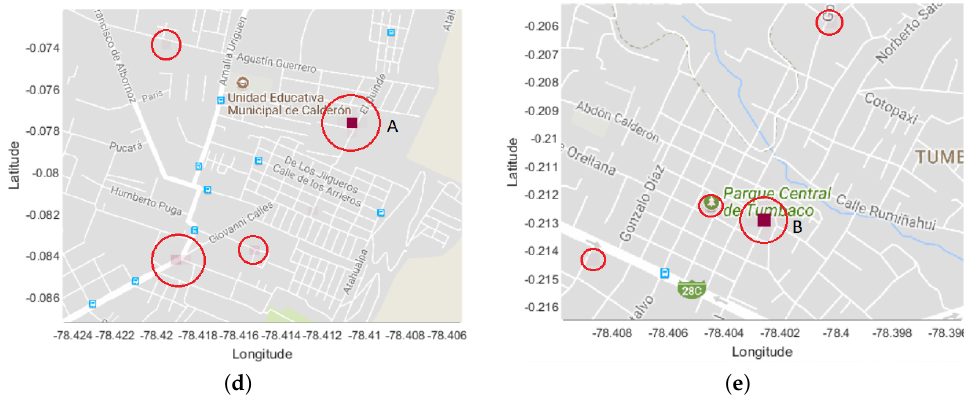
Figure 13. Analysis of fire brigade emergencies. ( a ) Events during 2014, with maximum and minimum peaks; ( b , c ) Parzen distribution in red gradient over the map and bidimensional probability density function (PDF); ( d , e ) Parzen kernel density deviation via diffusion (KDD) representations for maximum peaks, circled in red, during 21 September. Parzen–KDD permits us to visualize in short scale the exact location of events on the sectors of Carretas (A) and Tumbaco (B), respectively.